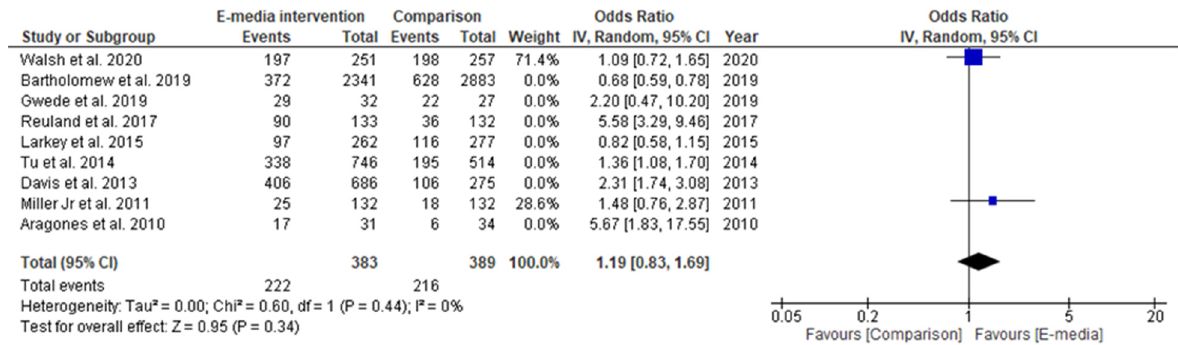
Figure 5. Funnel plot for studies eligible for meta-analysis ( n = 9).